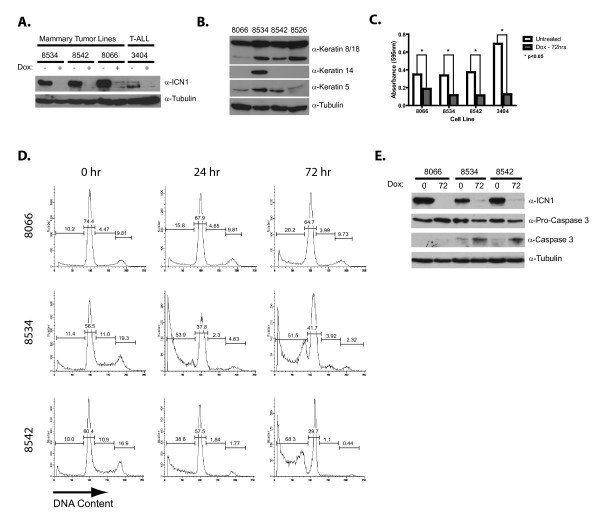
NOTCH1 inhibition induces apoptosis of mammary tumor cells. (A) NOTCH1 expression is rapidly suppressed in doxycycline-treated mammary tumor cell lines. Cell lines were left untreated or treated with doxycycline (2 μg/ml) for 24 hours, and lysates were analyzed for ICN1 expression with immunoblotting. A doxycycline-regulated T-ALL cell line 3404 is included as a control. (B) Mammary tumor cell lines express cytokeratin 8/18, but have variable expression of basal cytokeratins 5 and 14. Cell-line lysates were analyzed for CK8/18, CK5, and CK14 expression with immunoblotting. (C) NOTCH1 inhibition arrests mammary tumor cell growth. Three mammary tumor cell lines (8066, 8534, and 8542) and T-ALL cell line 3404 were left untreated or treated with doxycycline (2 μg/ml) for 72 hours, and cell growth was measured by using an MTT assay. The figure represents the average of three independent experiments, statistically analyzed by the Student paired t test. (D) NOTCH1 inhibition induces apoptosis of multiple mammary tumor cell lines. Tumor-derived cell lines 8066, 8534, and 8542 were treated with 2 μg/ml doxycycline or left untreated for 0, 24, or 72 hours. Cells were assayed for DNA content by staining with PI followed by flow cytometry. (E) NOTCH1 inhibition results in caspase 3 activation. Cells were left untreated or treated with doxycycline (2 μg/ml) for 72 hours, and lysates were analyzed for cleaved or total caspase-3 levels with immunoblotting.